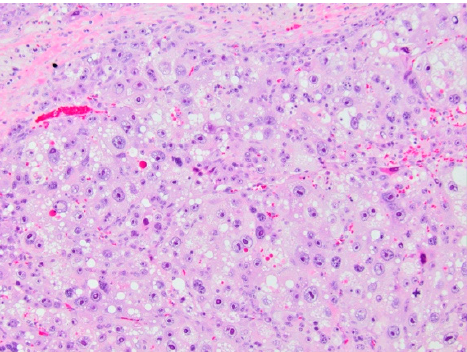
Figure 11. Conventional hepatocellular carcinoma (H&E, 10 × magnification). Malignant prolifera- tion of hepatocytes, with pleomorphism, large, prominent nucleoli, and abundant mitotic figures, including atypical